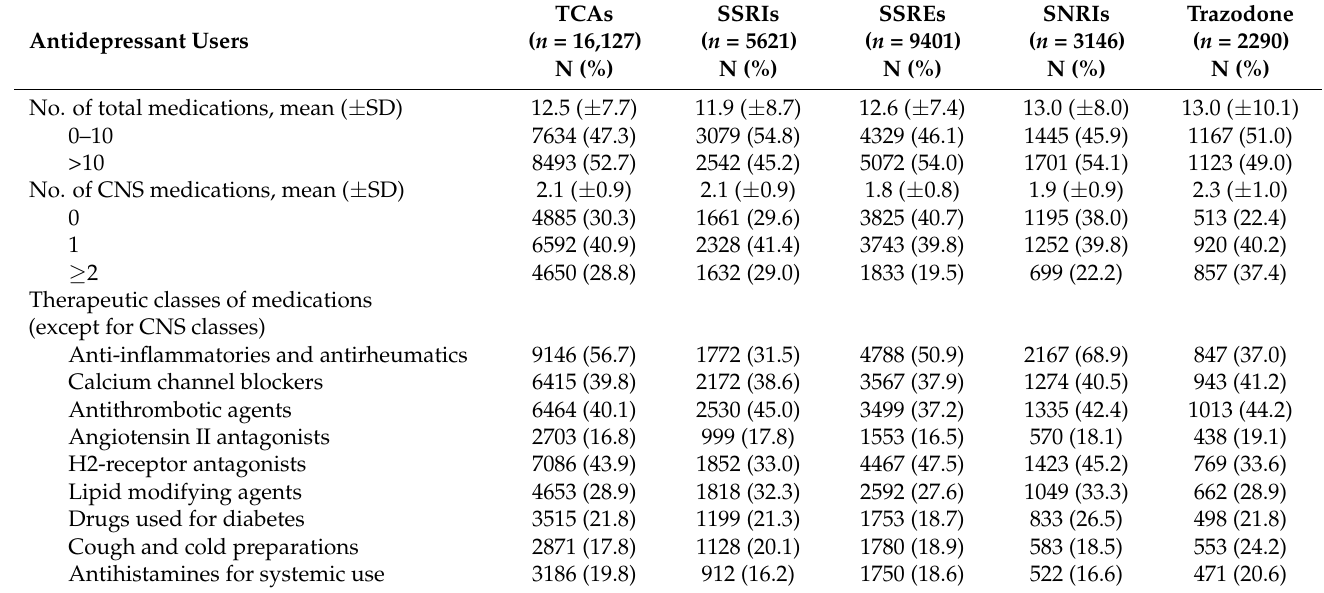
Table 2. The usage patterns of the medications used concurrently with the